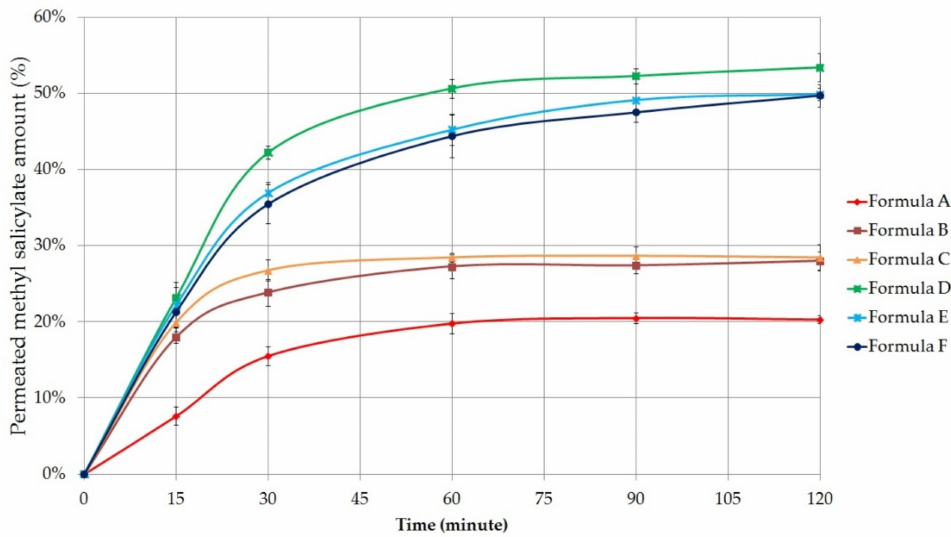
Figure 4. In vitro permeation profile of methyl salicylate across isopropyl myristate (IPM) impregnated cellulose acetate membrane from the formulation A–F. Bars represent mean ± S.D. ( n =